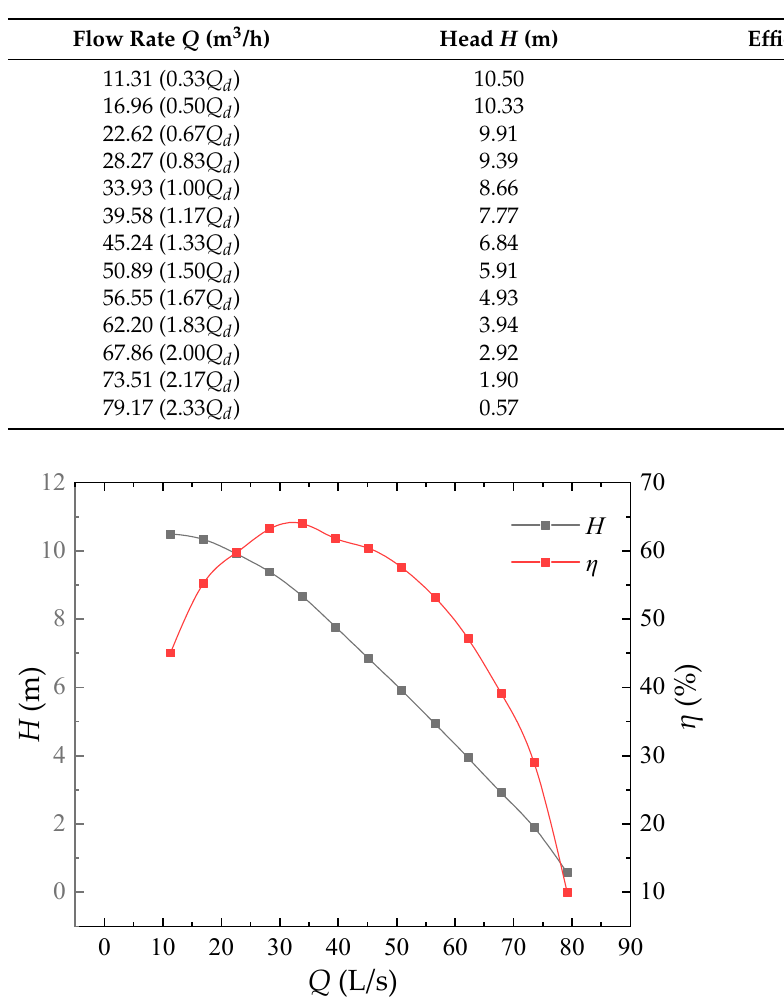
Figure 4. Energy characteristic curve at different flow rates.